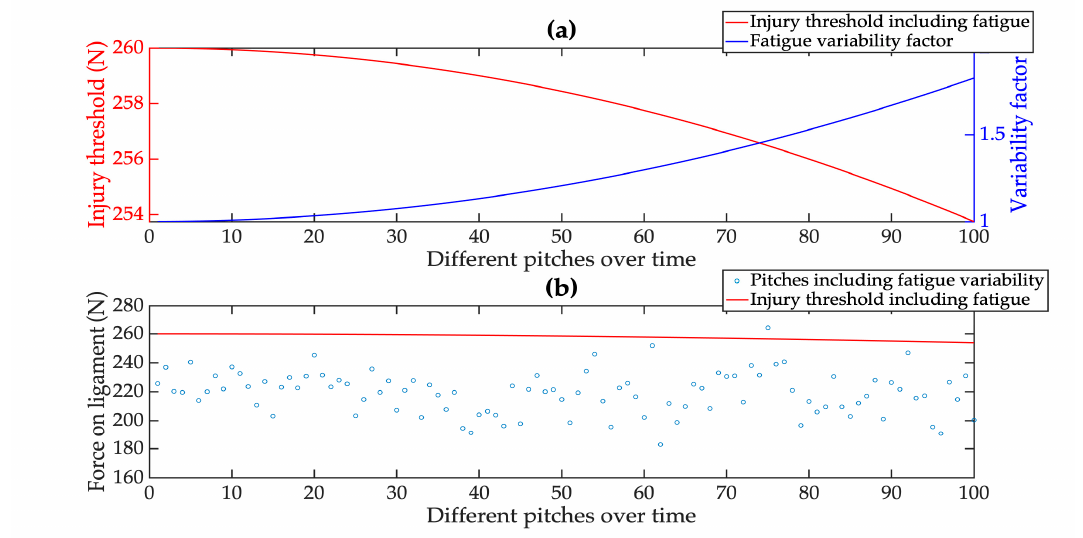
Figure 2. Data for simulation 3. ( a ) Blue line: non-linear fatigue variability factor over time. Red line: Non-linear negative adaptation of the injury threshold within a training/match. This curve is also represented in the lower panel. ( b ) The influence of a higher load variability on the UCL over time due to fatigue. Red line: the injury threshold, influenced by a non-linear negative adaptation within a training session or